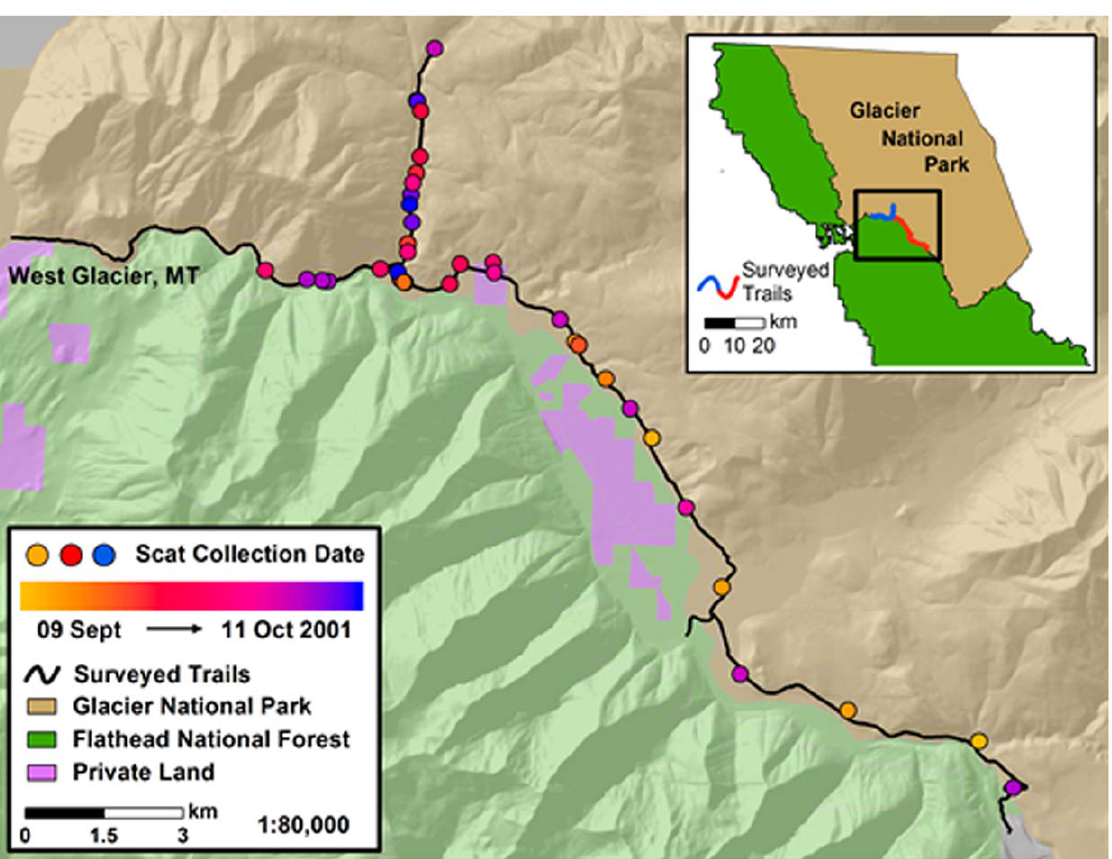
Figure 1. Map showing the location of surveyed trails and scats collected in Glacier National Park, Montana. Scats were collected during 09 Sept-11 Oct, 2001.